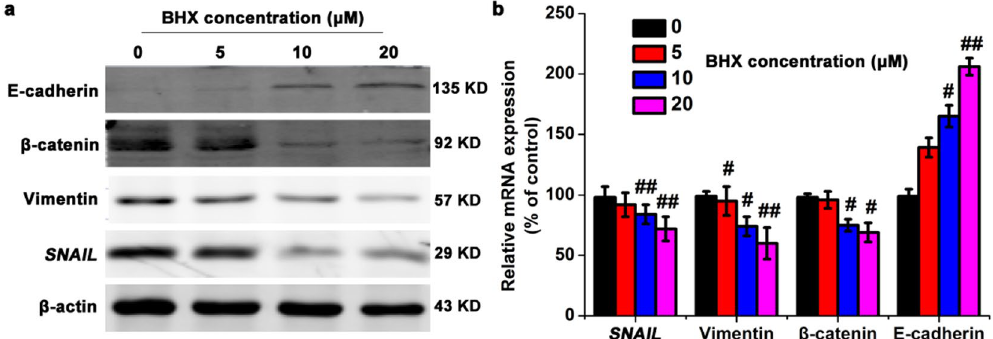
Figure 5. BHX alters the expression of proteins involved in EMT. (a) The effect of BHX on the protein expression levels of E-cadherin, β -catenin, Vimentin, and Snail, and β -actin was assessed by western blot. (b) The effect of BHX on the mRNA expression levels of E-cadherin, β -catenin, Vimentin, and Snail was assessed by PCR using GAPDH as a control. Data are represented as means ± S.D. from three independent experiments. # p < 0.05 and ## p <